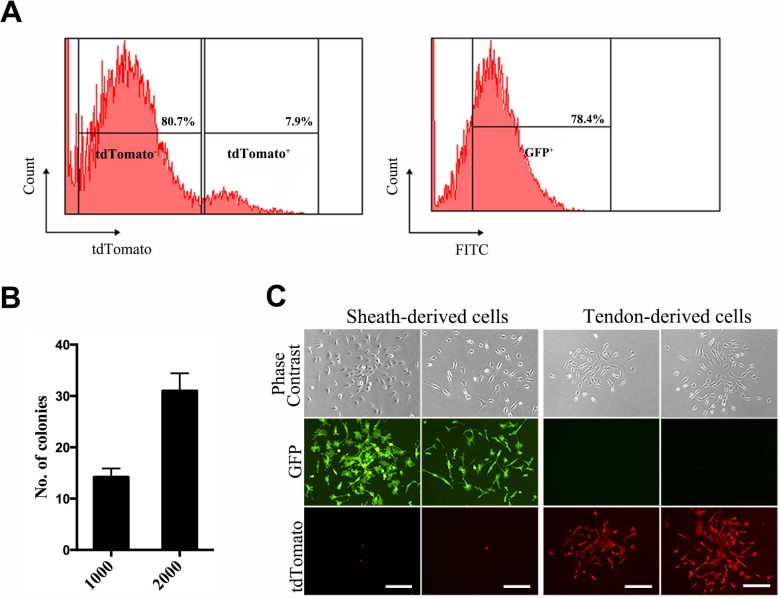
Fluorescence-assisted cell-sorting (FACS) analysis of sheath-derived cells.(A) Cells dissociated from the Tibialis anterior sheath tissues of the BGLAP-Cre;Rosa26mT/mG mice after cell-sorting for GFP and tdTomato signals. (B) The number of colonies was counted in a colony-formation assay using sheath-derived cells (GFP+) isolated from the BGLAP-Cre;Rosa26mT/mG mice with two different initial cell-seeding densities of 1000 or 2000 cells. (C) Cell morphology of sorted cells in vitro. Scale bar, 20 μm.10.7554/eLife.30474.004Figure 1—figure supplement 1—source data 1.Source data relating to Figure 1—figure supplement 1B.